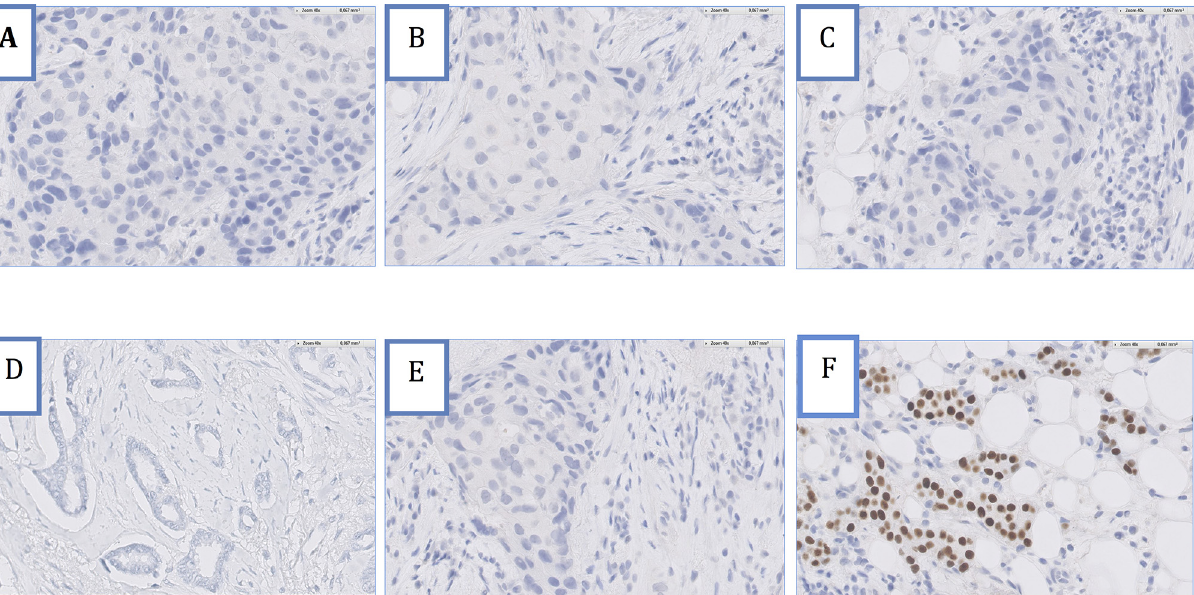
Fig 3. IHC pictures of 4 discordant cases for ER status. Patients (A-D) were IHC-negative/MapQuant-positive. Patient (E) was IHC-negative/MapQuant- negative. Patient (F) was IHC-positive 100%/MapQuant-positive.